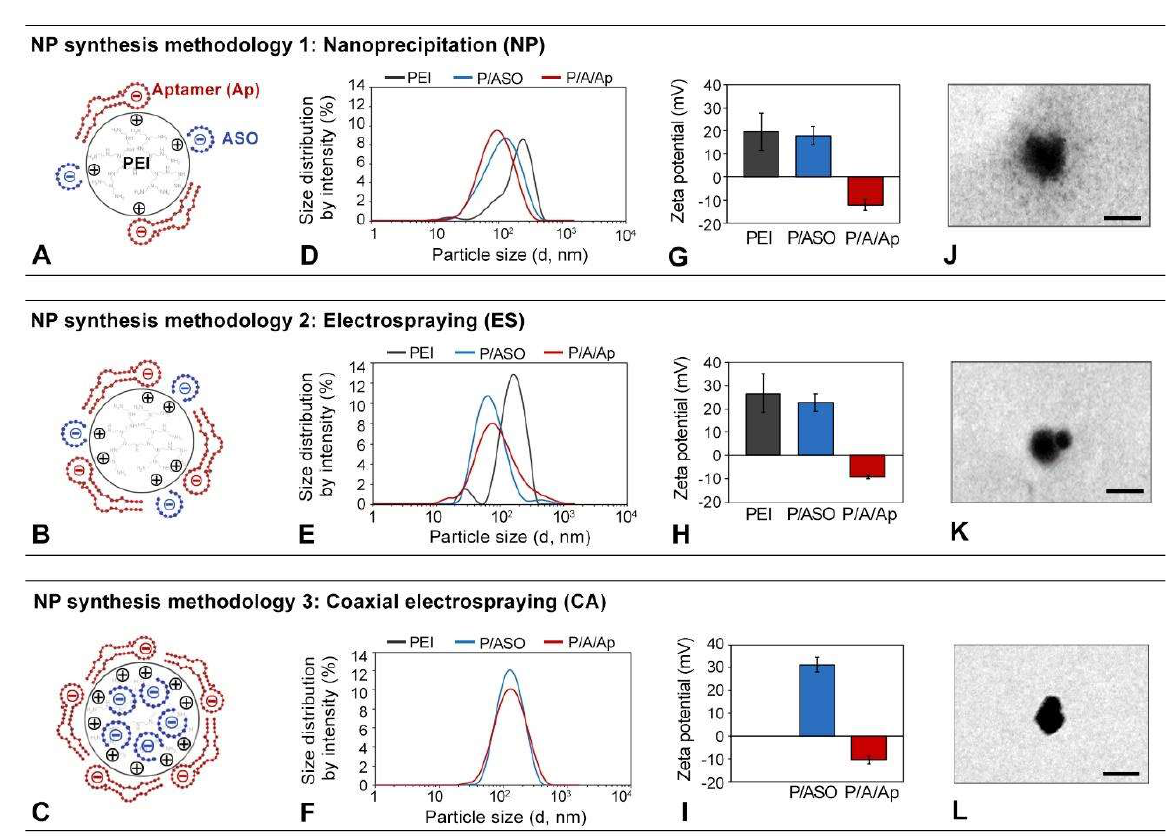
Figure 1. ( A – C ) Schematic depiction of the electrostatic structure of the PEI-cit/ASO/Ap nanocom- plex attained with the three synthesis methodologies: nanoprecipitation (NP, ( A )), electrospraying (ES, ( B )), and coaxial electrospraying (CA, ( C )). ( D – F ) Particle size distribution of the PEI-cit nano- complexes at different levels of functionalization (PEI-cit, PEI-cit/ASO, and PEI-cit/ASO/Ap) synthesized by the three methodologies: NP ( D ), ES ( E ), and CA ( F ). ( G – I ) Z-potential of the surface of the PEI-cit nanocomplexes at different levels of functionalization (PEI-cit, PEI-cit/ASO, and PEI-cit/ASO/Ap) synthesized by NP ( G ), ES ( H ), and CA ( I ). Note the decrement of the Z-potential due to the addition of the electronegative oligonucleotides (ASO, Ap) to the positively charged nanocore. ( J – L ) TEM images of PEI-cit/ASO nanocomplex morphology by: NP ( J ), ES ( K ), and CA ( L ). Scale bars: 180 nm.